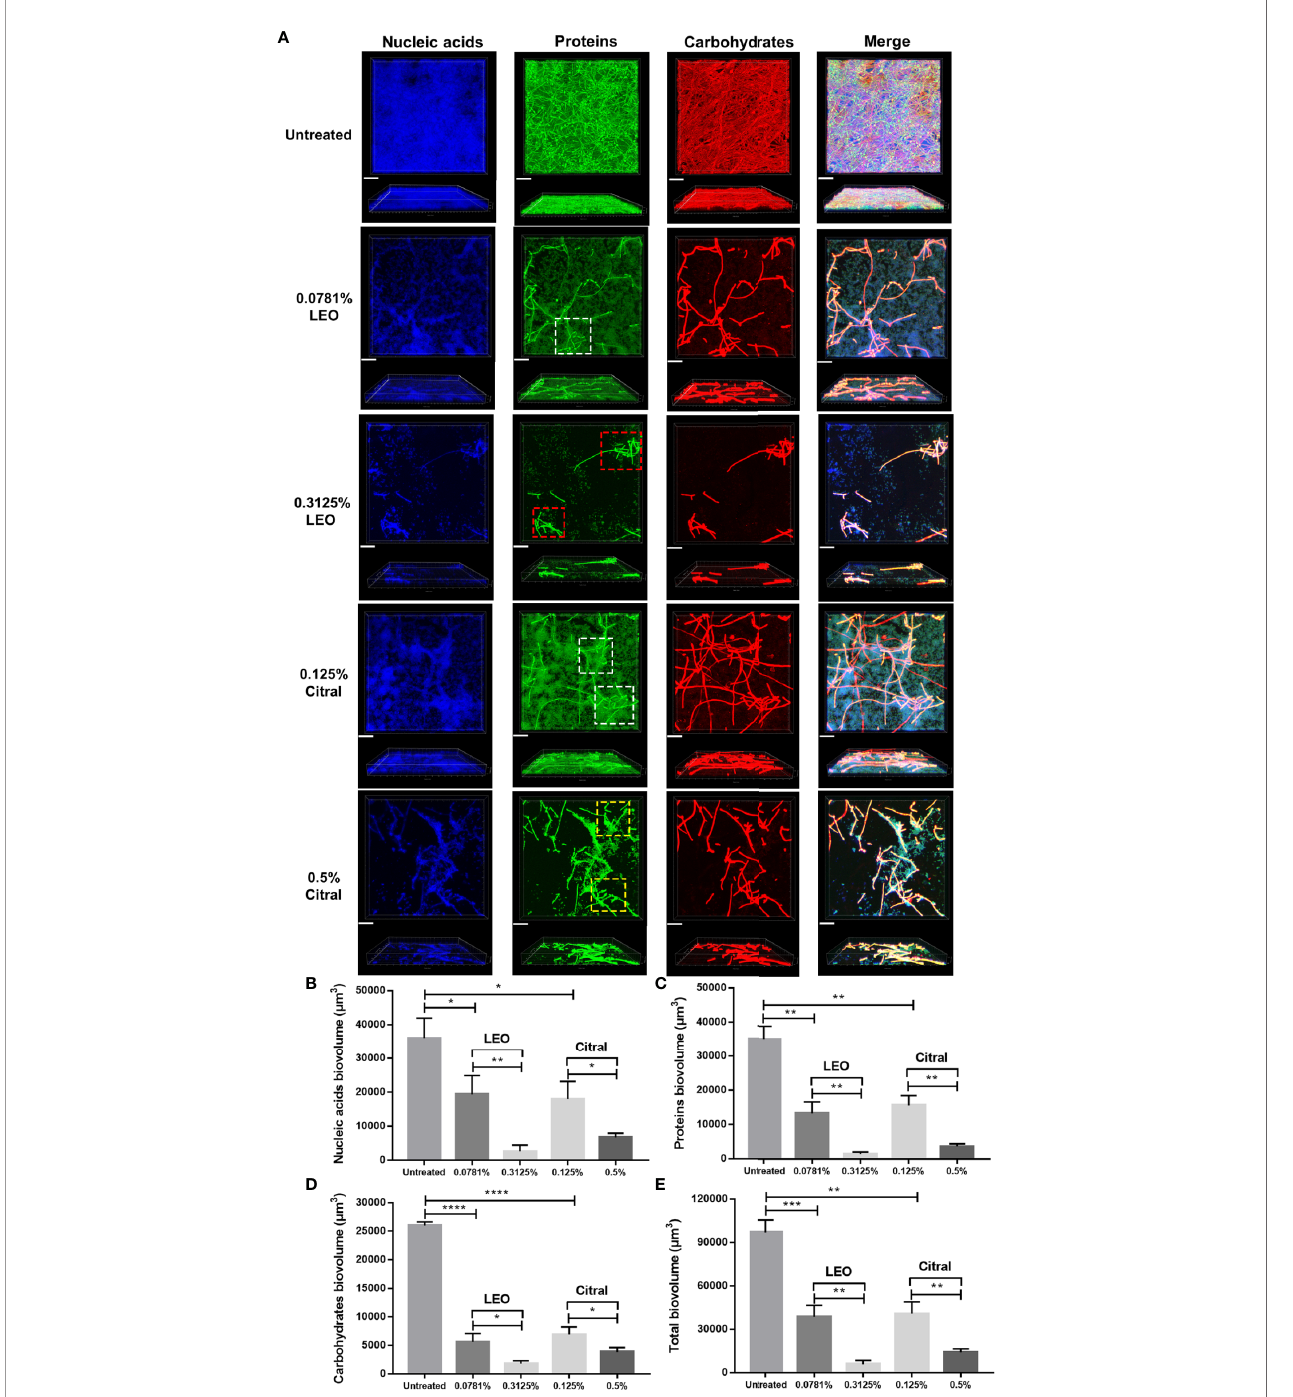
FIGURE 5 | Compositional analysis of dual-species bio fi lm matrix after lemongrass essential oil or citral treatment. (A) Alterations of nucleic acids, proteins and carbohydrates in bio fi lm matrix were visualized by CLSM. The upper fi gures show top view and the lower fi gures show side view of bio fi lms; Three fl uorescent dyes including DAPI, FITC and concanavalin A were applied to mark nucleic acids, proteins and carbohydrates, respectively. White, yellow and red squares (dotted lines) indicated high level adhesion, low level adhesion, and dissociation areas, respectively. The scale bar indicates 20 m m. (B) Comparison of the nucleic acids biovolume treated by LEO (or citral) and untreated control. (C) Comparison of the proteins biovolume treated by LEO (or citral) and untreated control. (D) Comparison of the carbohydrates biovolume treated by LEO (or citral) and untreated control. (E) Comparison of the total biovolume (nucleic acids + proteins + carbohydrates) treated by LEO (or citral) and untreated control. Data are shown as mean ± SD (n=4), *p < 0.05, **p < 0.01, ***p < 0.001, ****p < 0.0001. LEO, lemongrass essential